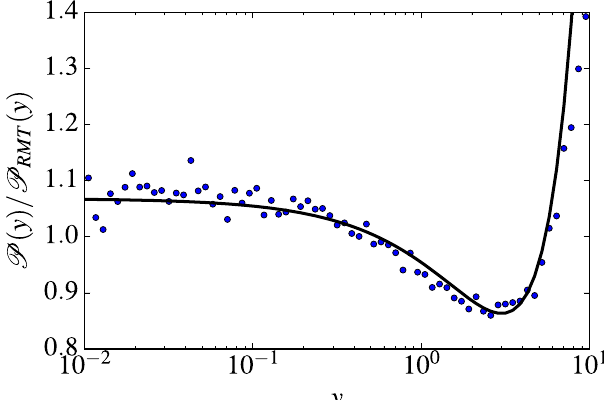
Figure 4. Blue dots: the intensity distribution calibrated with respect to the RMT result for 10% of the pinned sites at E ≈ 3.5. Solid line: fit with theory (31) with g = 5.63 and L / l =